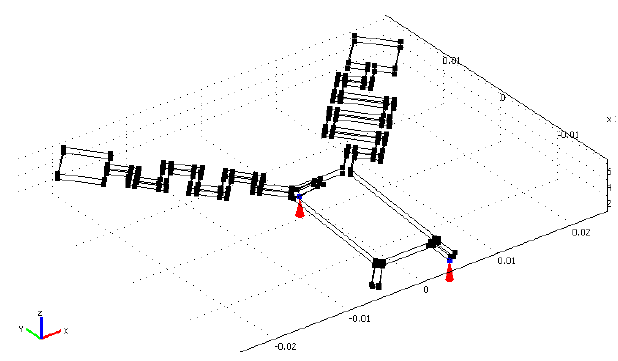
Figure 3. Illustration of boundary conditions for COMSOL simulation.